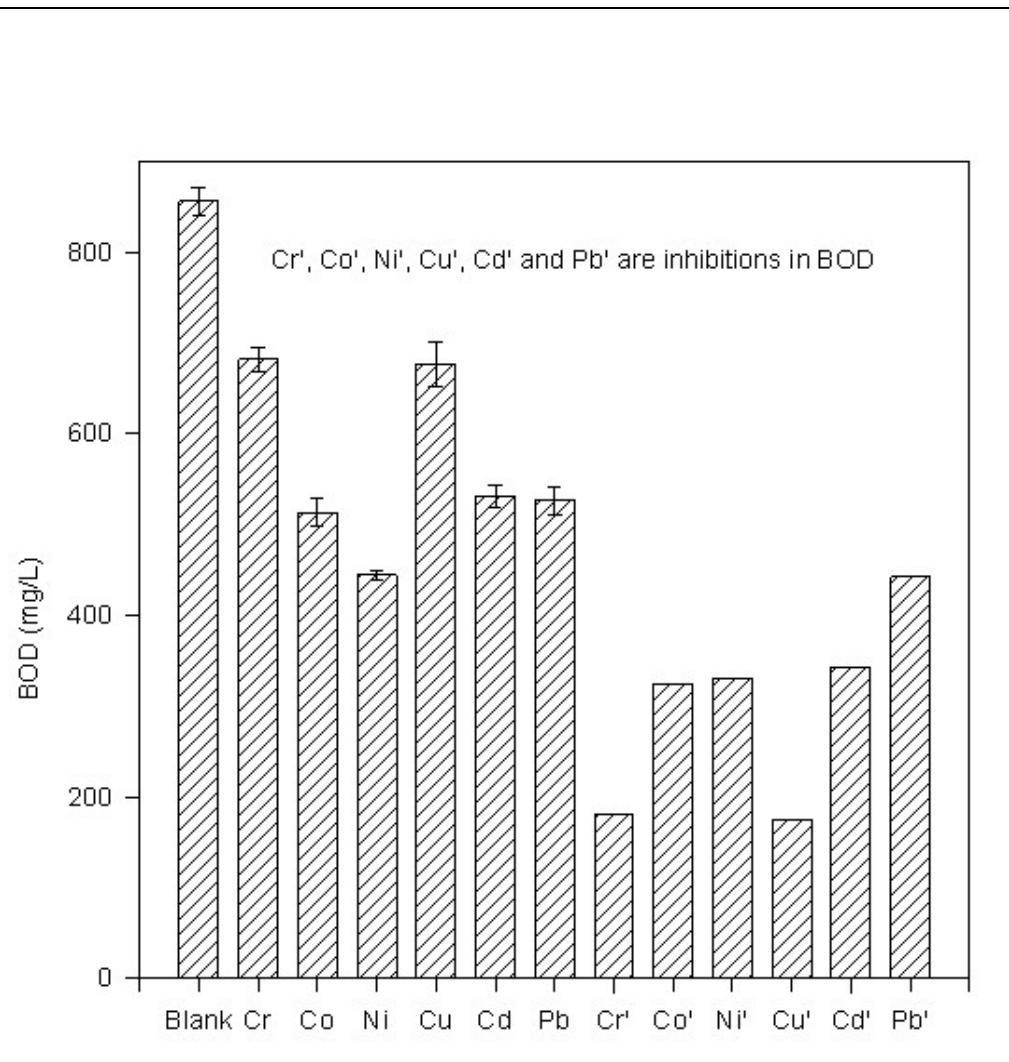
Figure 1 : Histogram of BOD in presence of metal ions at 15 0